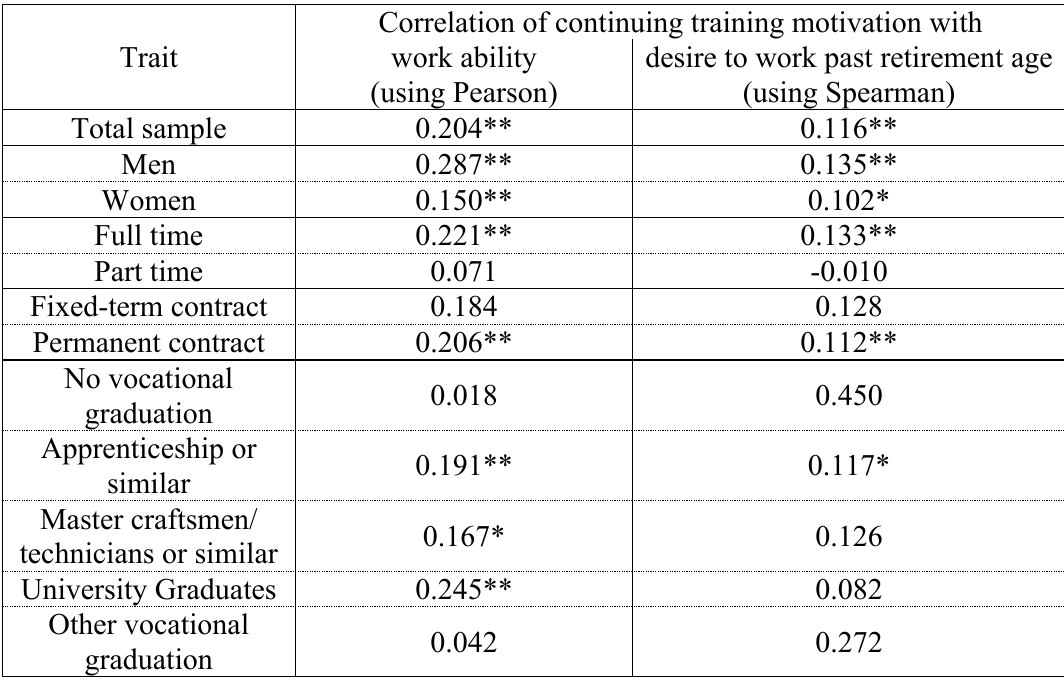
Table 2 . Correlation of continuing training motivation with work ability and with desire to work past retirement age for selected respondent groups (**…significant correlations at the p<.01 level, *…at the p<.05